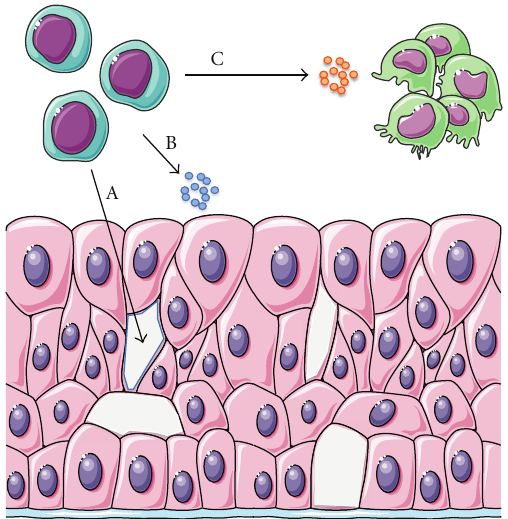
Figure 2: Stem cells participate in tissue regeneration in di ff erent ways. They directly di ff erentiate into tissue-specific cells and thus substitute damaged or lost cells (A). They indirectly influence tissue regeneration by secretion of soluble factors. Here they promote vascularization, cell proliferation, di ff erentiation within the tissue (B) and modulate inflammatory processes